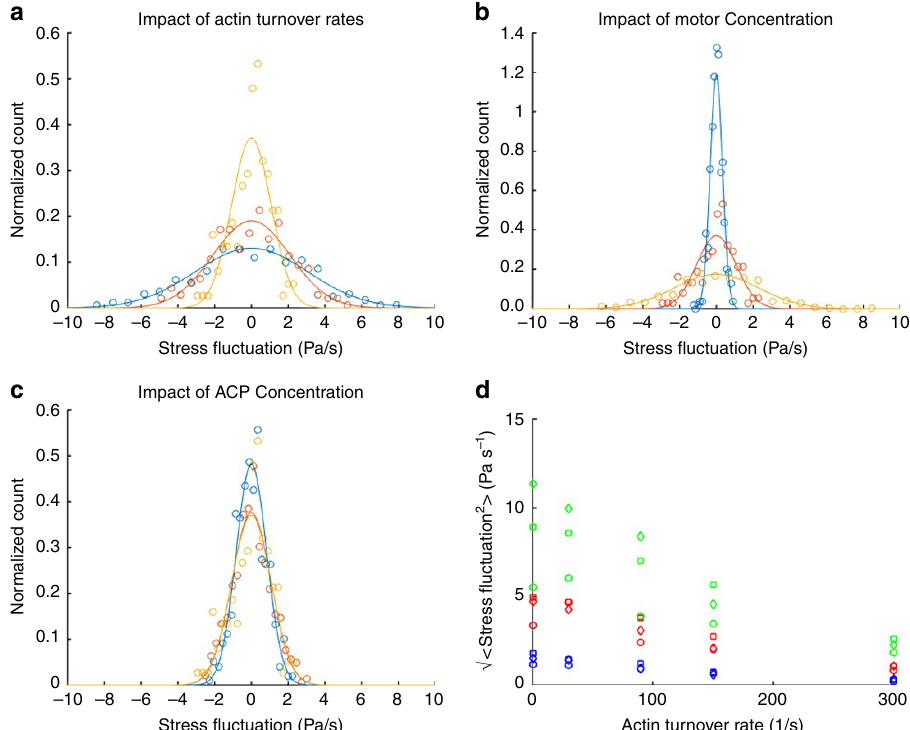
Figure 5 | Stress fluctuation magnitudes are modulated by network turnover and motor activity. ( a ) Network configuration (10% ACPs, 1% motors). Increasing the actin turnover rate from 90 (blue) to 150 (red) to 300s (cid:3) 1 (blue) leads to a decrease in the spread of the stress fluctuations. ( b ) Network configuration (10% ACPs, 300s (cid:3) 1 actin turnover rate). Increasing the motor concentration from 0.1% (blue) to 1% (red) to 5% (yellow) increases the s.d. of the stress fluctuation distribution. ( c ) Network configuration (1% motors, 300s (cid:3) 1 actin turnover rate). Increasing the ACP concentration from 1% (blue) to 5% (red) to 10% (yellow) does not appear to alter the s.d. of the stress fluctuation distribution. Stress fluctuations were measured over a total area of 27 m m 2 (9 m m 2 in each orthogonal axis) in each simulation domain. Stress fluctuation distributions from computational data (circles) were normalized and fitted to a normalized Gaussian with identical s.d. (lines). ( d ) Amplitude of stress fluctuations. Blue, red and green correspond to motor concentrations of 0.1%, 1% and 5%, respectively. Circles, squares and diamonds correspond to ACP concentrations of 1%, 5% and 10%, respectively. Percentages are relative to the actin concentration of 25 m M used in these